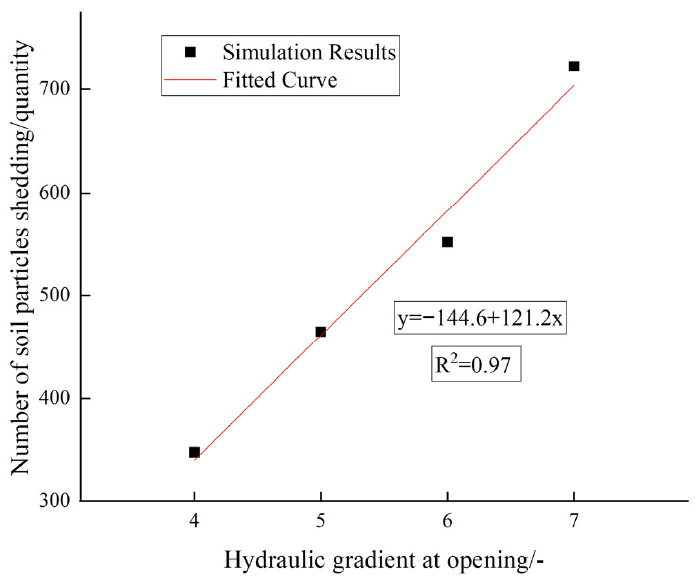
Figure 6. The effect of water pressure on drainage and shedding of soil particles.